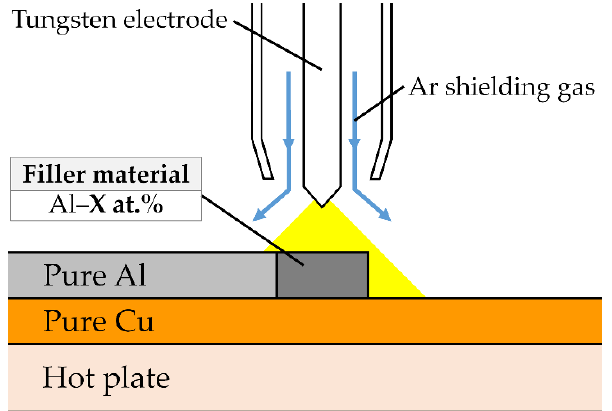
Figure 1. Schematic of dissimilar tungsten inert gas (TIG) arc brazing.